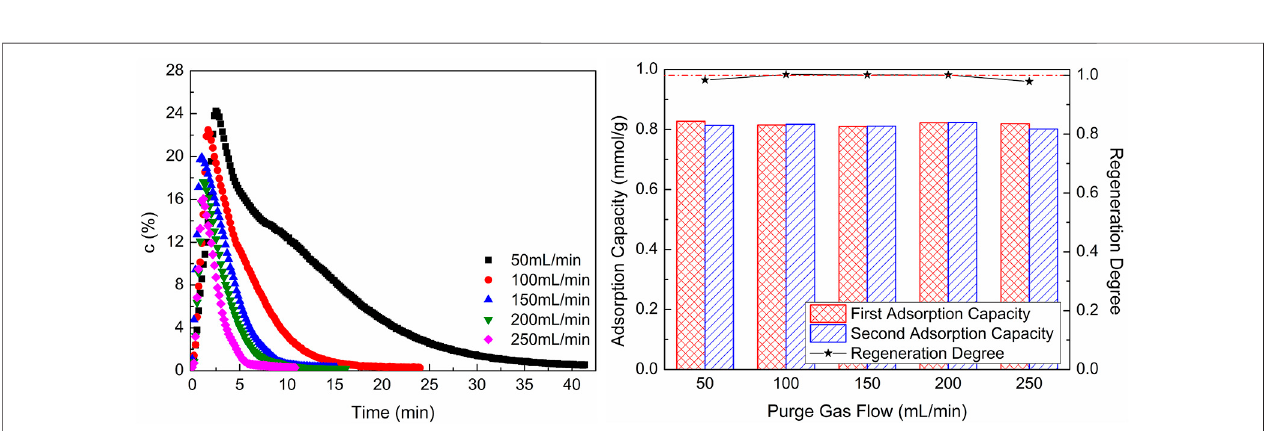
FIGURE 9 | CO 2 desorption properties at different sweep gas fl ows: (A) CO 2 desorption concentration; (B) adsorption capacity and regeneration degree.